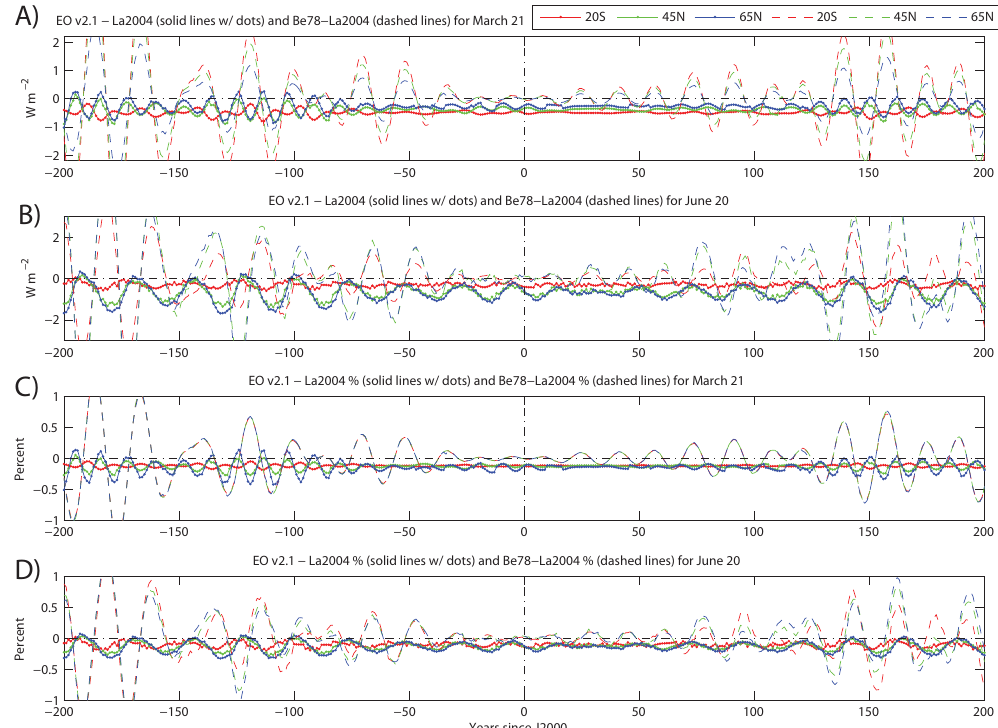
Figure 5. Absolute differences (Wm − 2 , solid lines with dots) between our insolation solution (using the La2004 astronomical parameters) and the Laskar (2014) insolation solution (also using the La2004 astronomical solutions; insolation provided by his Windows pre-compiled package at http://www.imcce.fr/Equipes/ASD/insola/earth/binaries/index.html) for 21 March (A) and 20 June (B) . Differences between the Be78 and La2004 astronomical solutions (insolation for both computed by our model) are shown for comparison with dotted lines. Data are shown for three different latitudes – 20 ◦ S (red), 45 ◦ N (green), and 65 ◦ N (blue). (C) same as in (A) but displaying percent insolation difference, (D) same as in (B) but displaying percent insolation difference. Earth Orbit v2.1 insolation computations use the model’s own orbital geometry with no additional a priori input other than the Milankovitch parameter solutions of La2004. Negative years are in the past. See Sect. 5.1 for